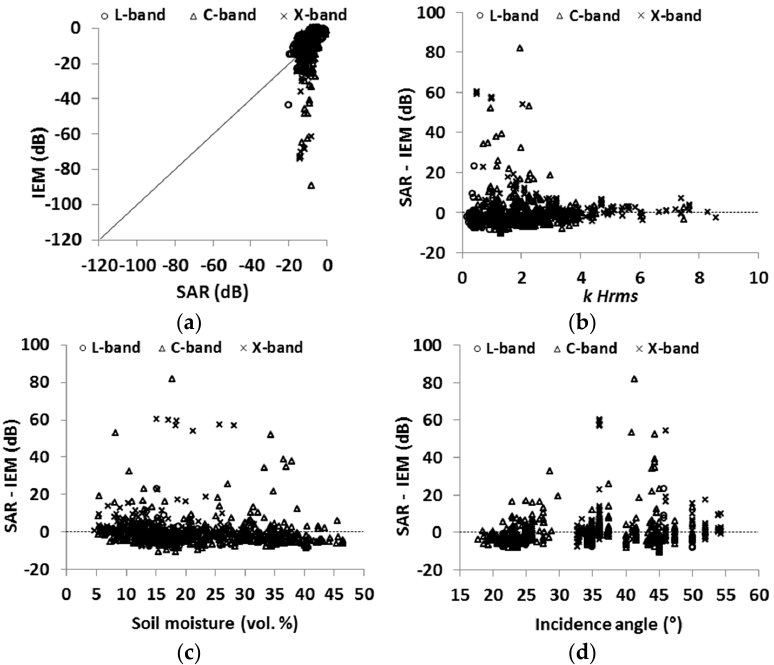
Figure 7. Comparison between backscattering coefficients derived from SAR images and those estimated from IEM at VV polarization using GCF. ( a ) IEM simulations vs. SAR data; ( b ) difference between SAR signal and IEM vs. soil roughness ( kHrms ); ( c ) difference between SAR signal and IEM vs. soil moisture ( mv ); ( d ) difference between SAR signal and IEM vs. incidence angle.